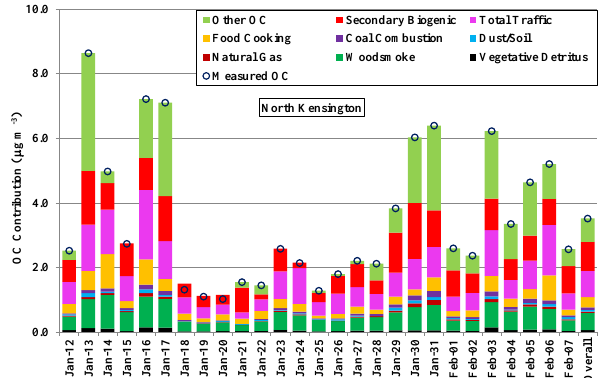
Figure 2. Daily OC source contribution estimates with secondary biogenic components at NK.